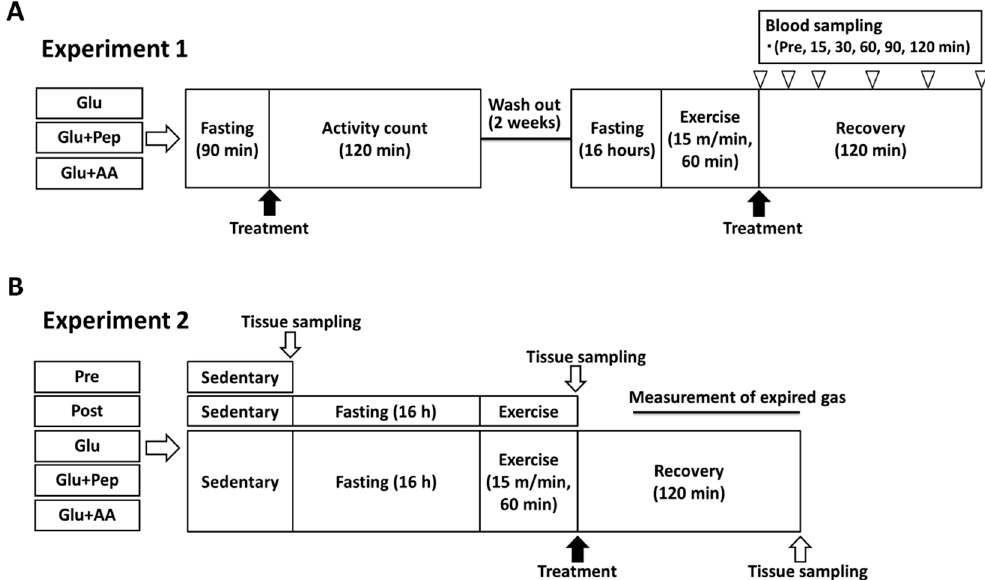
Figure 1. Experimental procedure. ( A ) Experiment 1: Assessments of locomotor activity and blood substrate concentrations after supplementation. ( B ) Experiment 2: Evaluation of muscle glycogen and measurement of expired gas. Pre: pre-supplement and sedentary group. Post: immediately post-exercise group. Glu: glucose ingestion group. Glu + Pep: glucose with casein peptide ingestion group. Glu + AA: glucose with amino acid ingestion group.